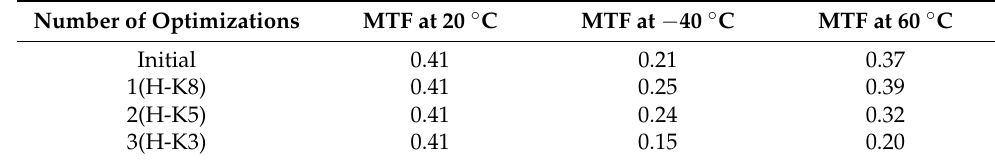
Table 4. The MTF at 68 lp/mm of the optical system after multiple structure optimization. Number of